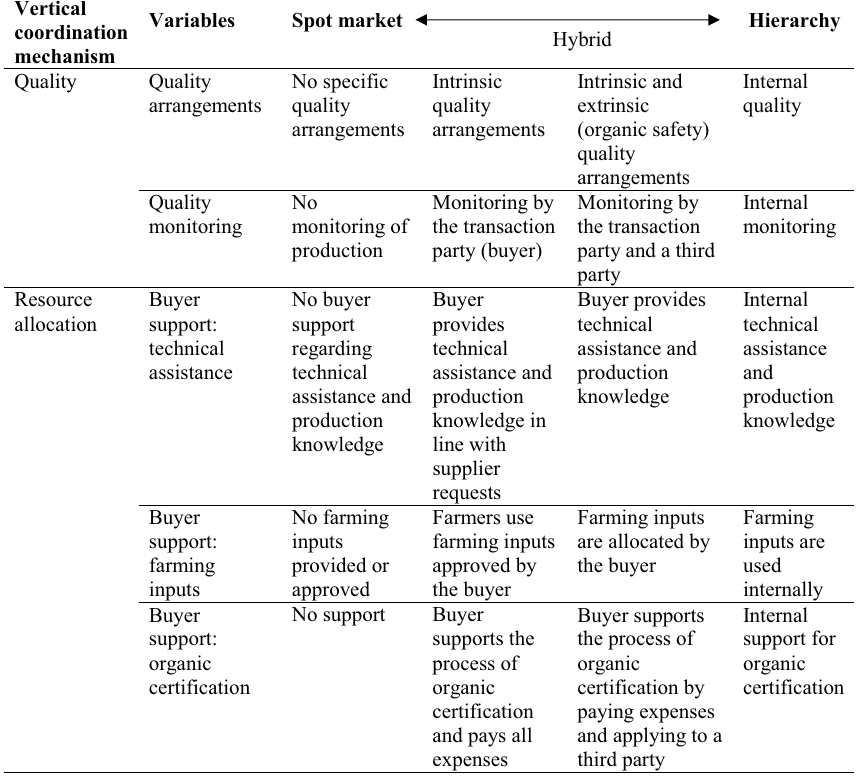
Table 2 Vertical coordination mechanisms regarding quality and resource allocation on the governance structure